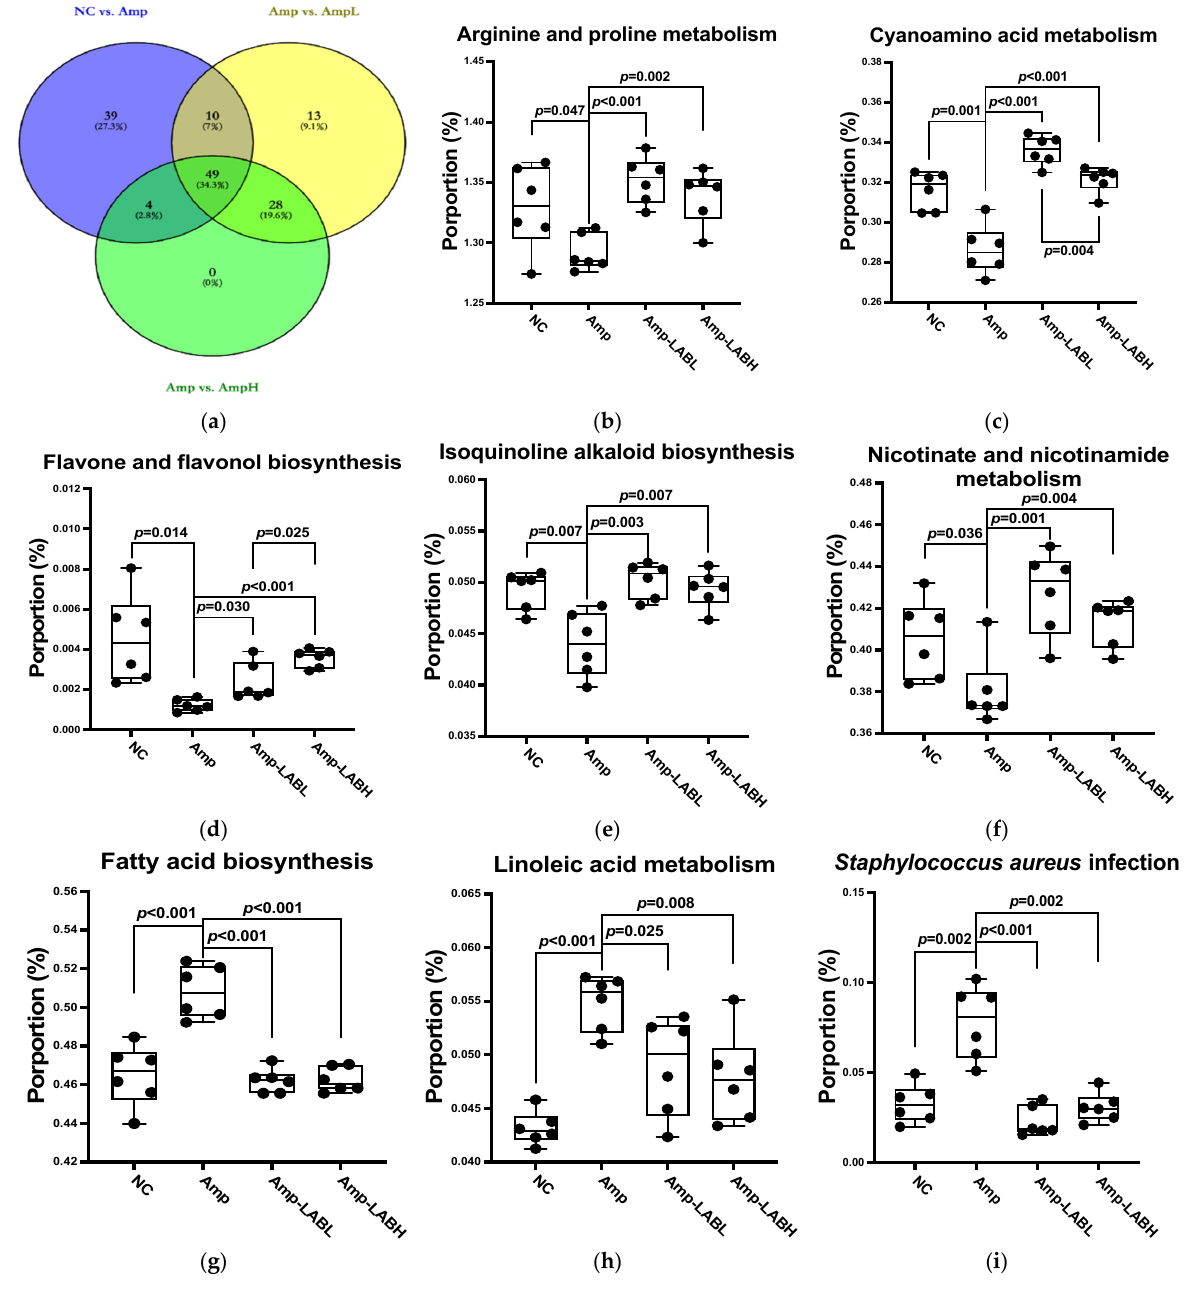
Figure 5. Effect of Lactobacillus spp. on gut microbes that regulate functional pathways in C57BL/6J mice. Based on the analysis of 16S ribosomal RNA V3 − V4 gene expression in the ileum, PICRUSt2 software was used for functional pathway prediction. ( a ) Venn diagram analysis of different func- tional pathways between the four groups. The dramatic difference between the Amp and LAB groups includes 49 pathways, such as ( b ) arginine and proline metabolism, ( c ) cyanoamino acid metabolism, ( d ) flavone and flavonol biosynthesis, ( e ) isoquinoline alkaloid biosynthesis, ( f ) nicotinate and nicoti- namide metabolism, ( g ) fatty acid biosynthesis, ( h ) linoleic acid metabolism, and ( i ) Staphylococcus aureus